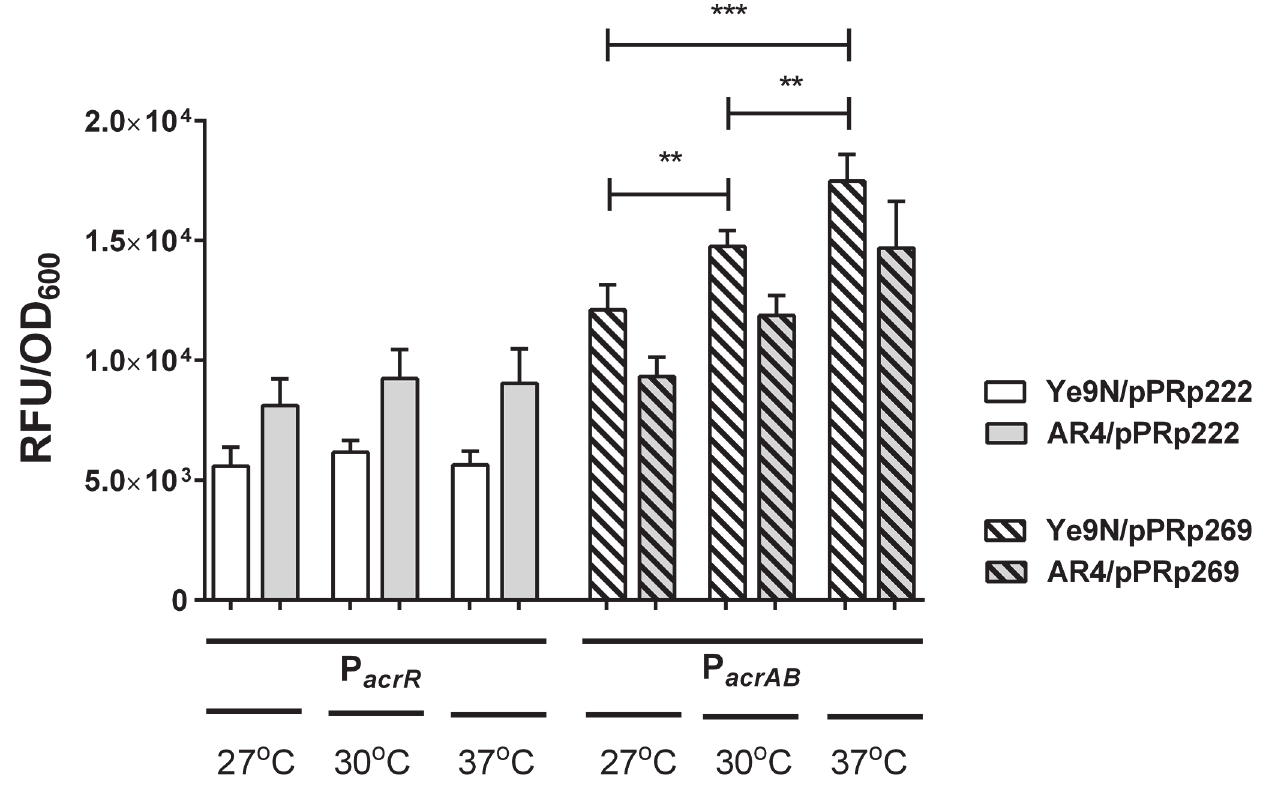
Fig 6. The influence of growth temperature on acrR and acrAB promoter activity. Strains Ye9 and AR4 carrying the promoter- gfp fusion constructs were cultivated in LB medium at 27°C, 30°C or 37°C to exponential phase. Data represent mean fluorescence activity values normalized to the OD 600 of the culture ( ± standard deviation) from three independent experiments performed in triplicate. Significance of differences between the values was calculated using Student ’ s unpaired t -test ( ** — p < 0.01, *** — p < 0.001).